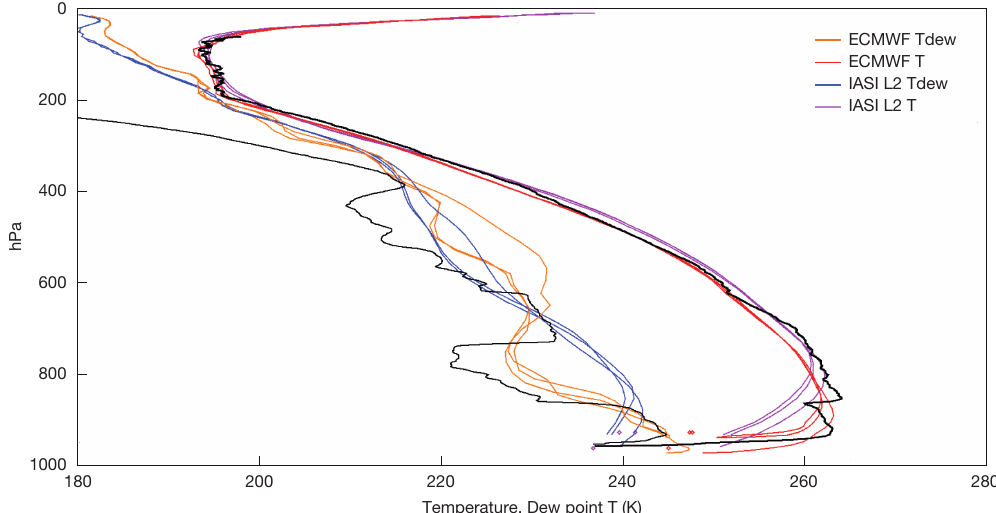
Figure 28. This Figure shows an example of a dropsonde vertical profile of temperatures (in black) on 23/10/2010 together with nearest ECMWF model profiles (in red and orange) and EUMETSAT IASI retrievals (in magenta and blue). Courtesy of Thomas August,